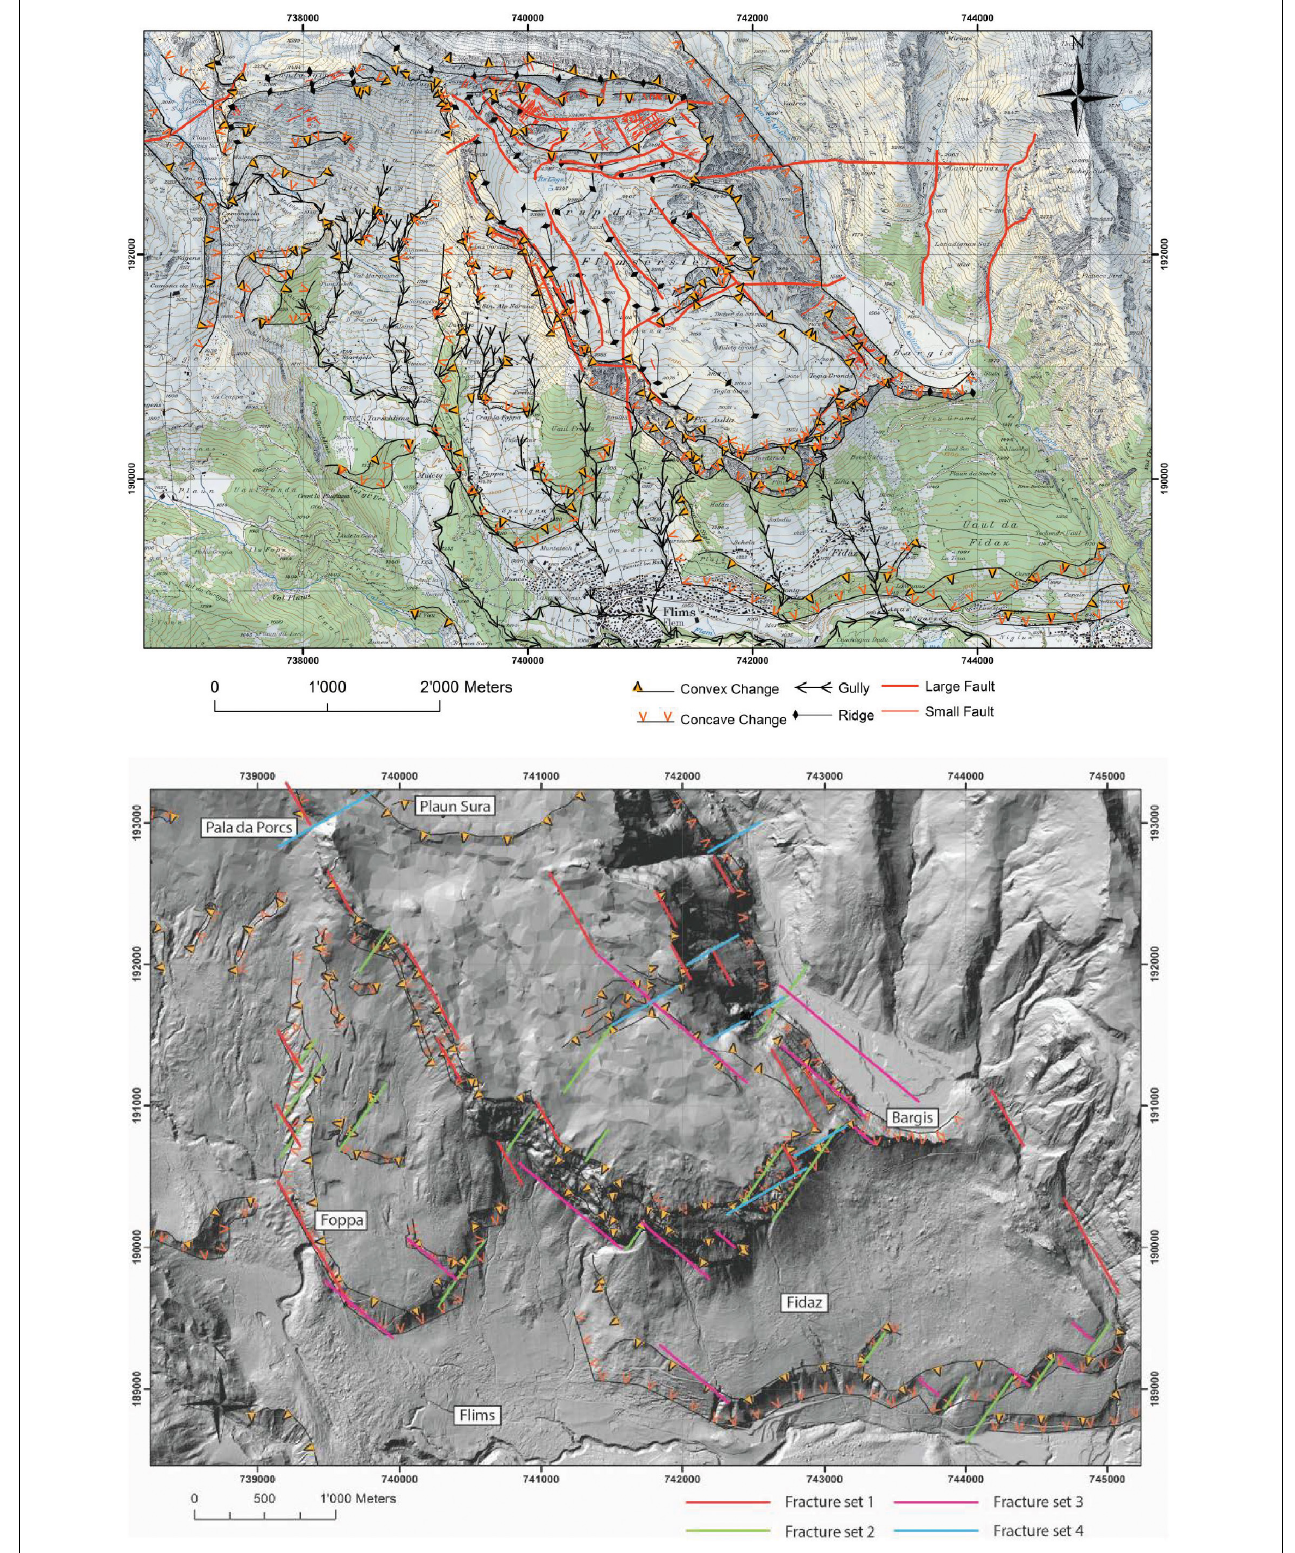
FIGURE 9 | Top: Geomorphological and structural geological map, indicating convex and concave changes in slope, gullies, ridges, and faults. Bottom: Surface expression of fracture sets 1–4 overlain on the geomorphology of the study area.